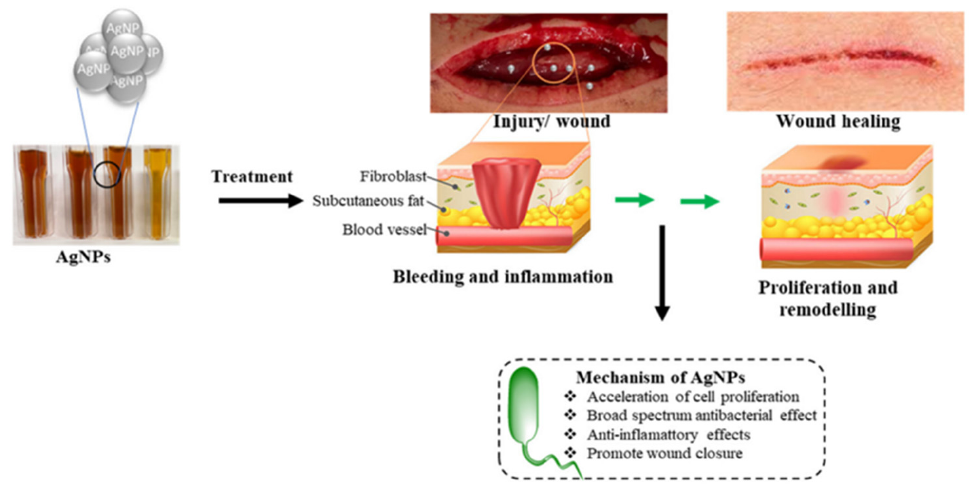
Figure 4. Images showing the action of silver ions in wound dressing. Reprinted with permission from MDPI [76]. 2022, Karthik V Shankar.